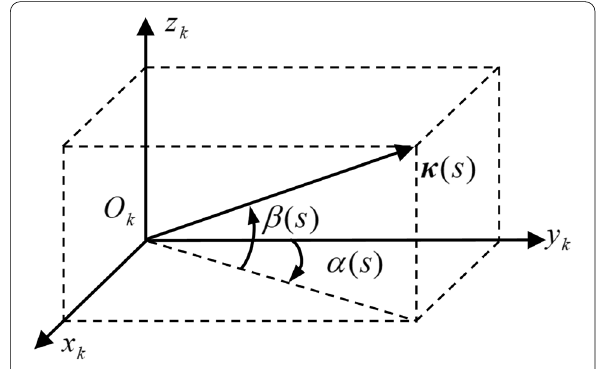
Figure 4 Parameterization of κ ( s ) , α( s ) , and β( s